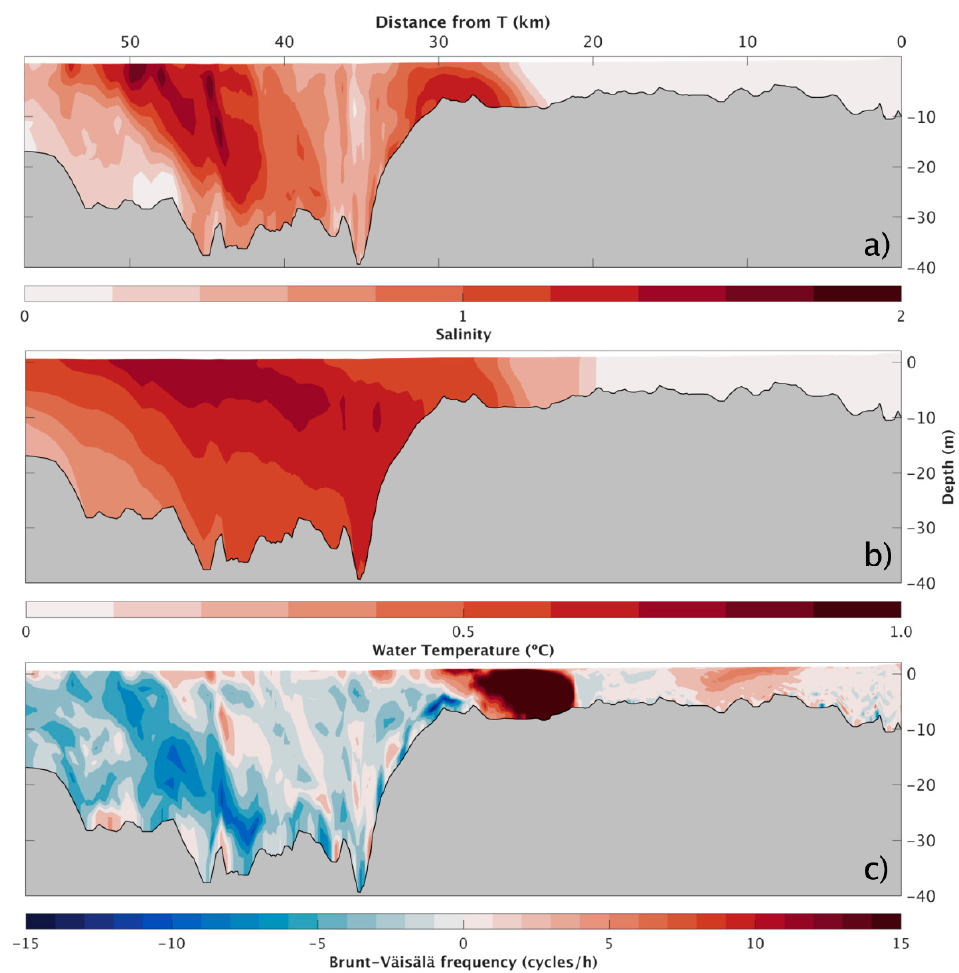
Figure 10. Difference between #Sc4 and #ScRef, in terms of ( a ) salinity; ( b ) water temperature; ( c ) Brunt–Väisälä frequency.